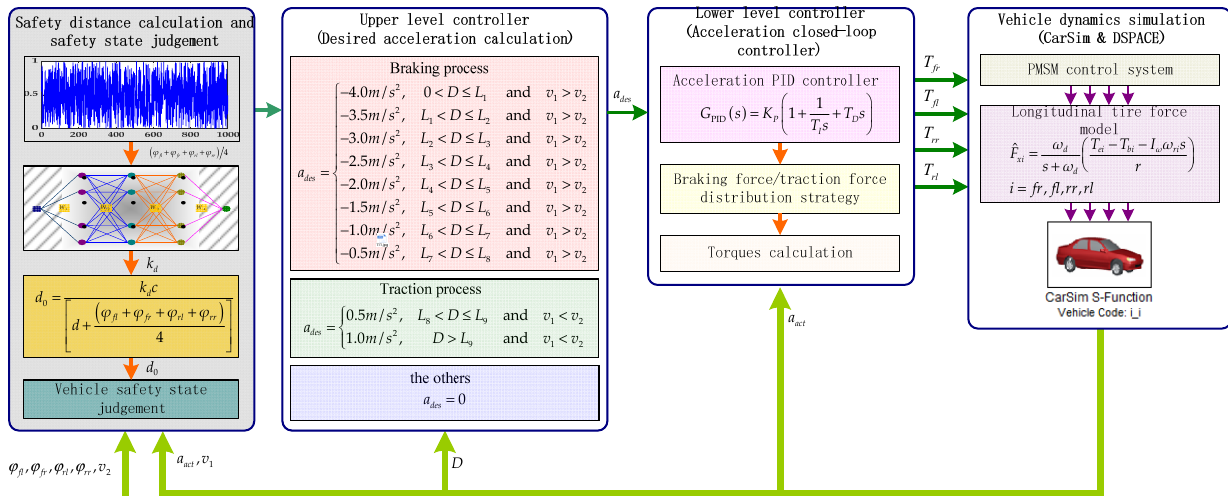
Figure 4. Hardware platform of the active collision avoidance control system.